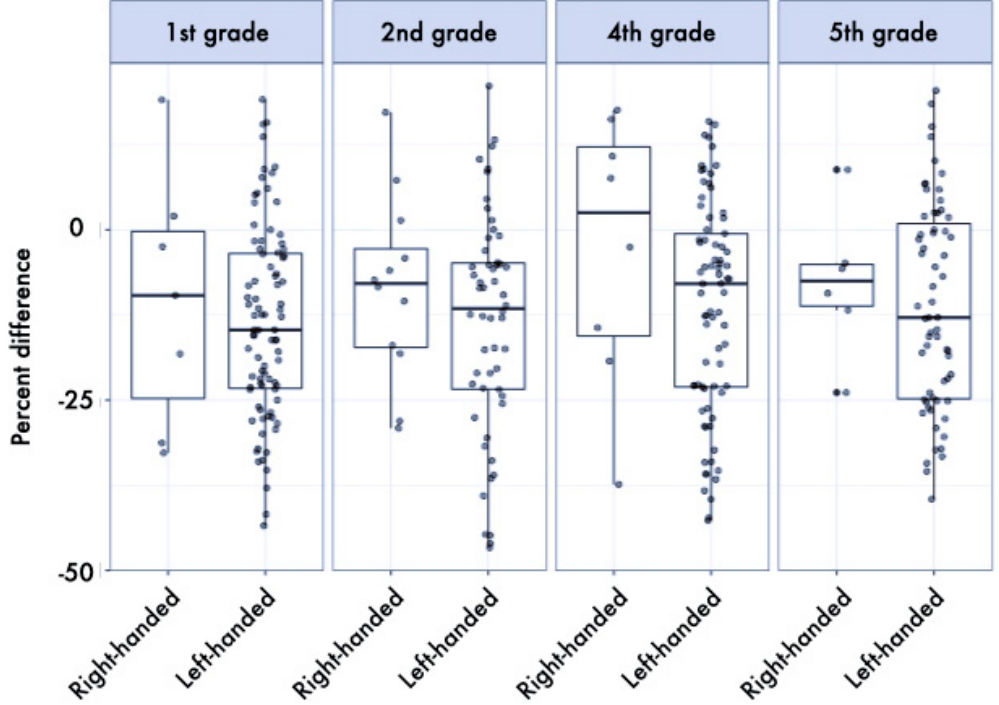
Figure 2. Boxplot (median and interquartile range, and individual values) of percent di ff erences between dominant and non-dominant hand in the Floppy test stratified by school grade and hand preference. Values below 0% indicate better performance of the dominant hand. The median of the asymmetry index in favor of the dominant side was 7.37% for left-handed and 12.56% for right-handed children. Table 3. Results of the Thumb test (time to completing) stratified by school grade and hand preference. Lower values denote better results.